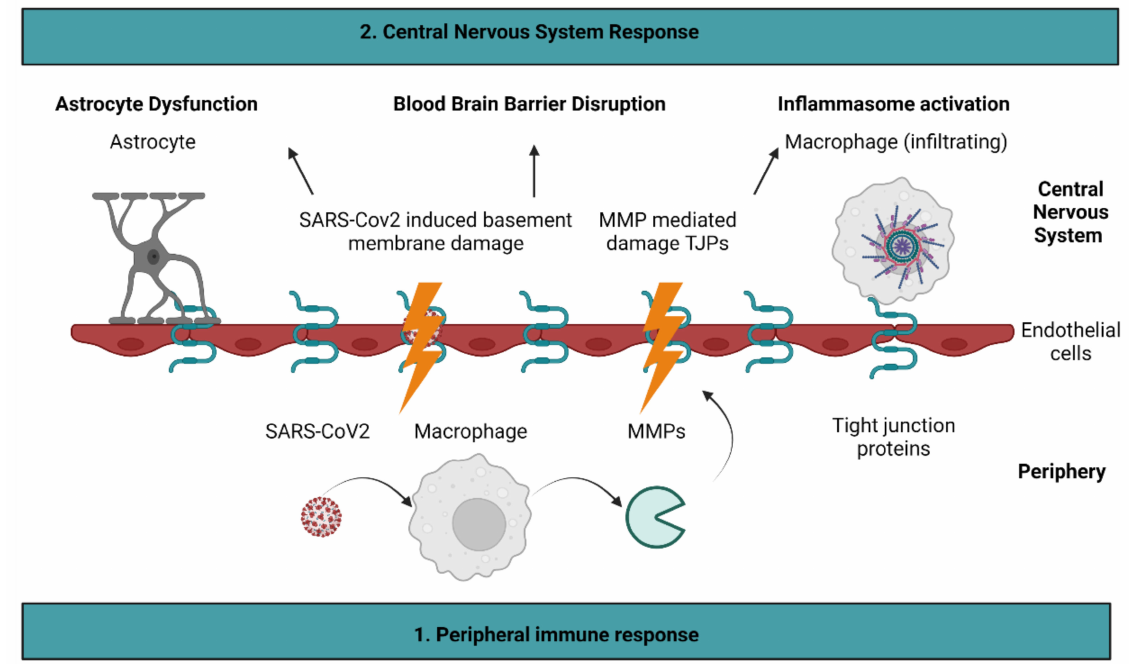
Figure 2. Proposed molecular mechanisms of COVID-19 induced stroke. It is proposed that COVID- 19 stimulates the release of matrix metalloproteinases (MMPs) by macrophages. As a result, MMPs cleave tight junction proteins present on endothelial cells. Damage to endothelial cells is exacerbated directly by the SARS-CoV2 virus, which alters basement membrane integrity. Endothelial cell injury leads to blood–brain barrier permeability, which results in astrocyte dysfunction and inflammasome activation. Figure created with